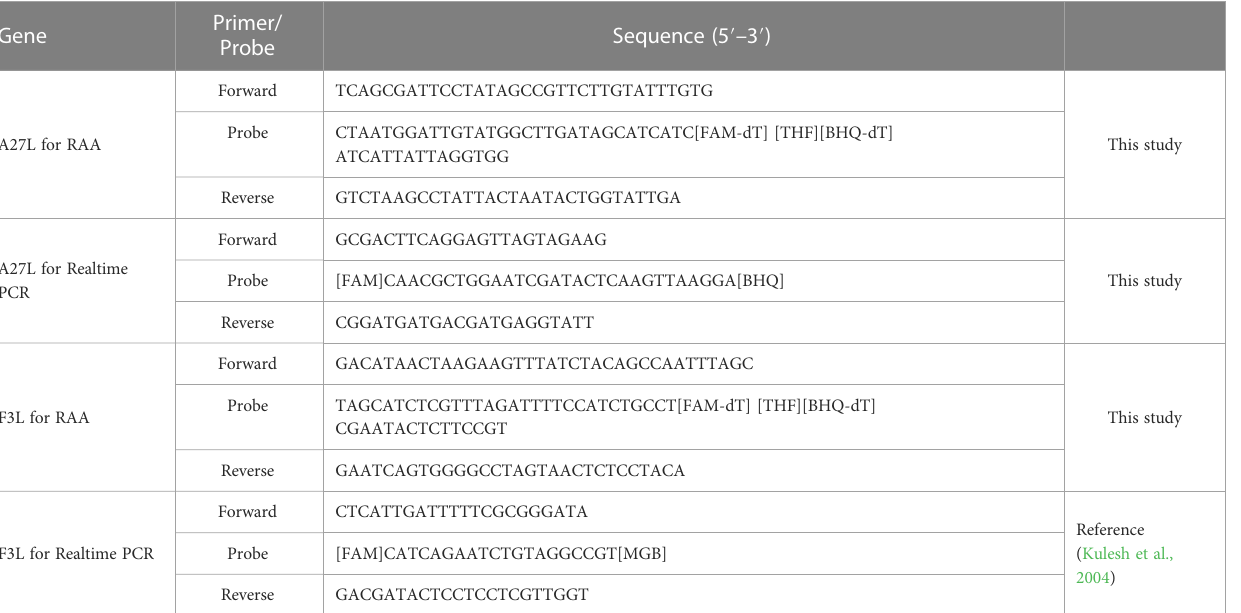
TABLE 1 Sequences of the primers and probes used for the RAA assay.